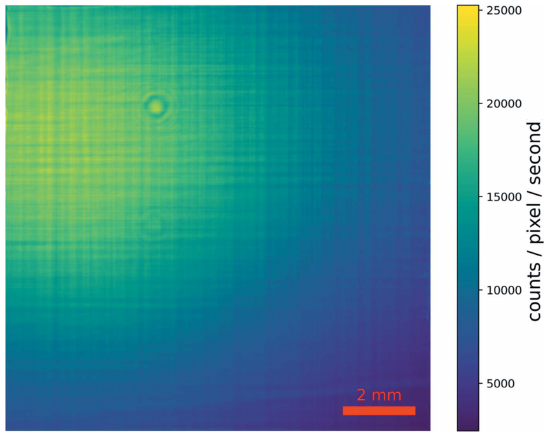
Figure 6 A far-field image of the transmitted beam as measured on a high- resolution sCMOS camera (ANDOR Zyla 4.2, 6.5 m m pixel size) coupled with a 10 (cid:5) magnification optical element and a 10 m m-thick LuAG:Ce fluorescence screen. The camera was positioned at 1.12 m from the focal plane and the beam fills the whole camera field of view. The scale bar refers to the camera dimensions. The uniform distribution of intensity is an indication of the great quality of the KB mirror